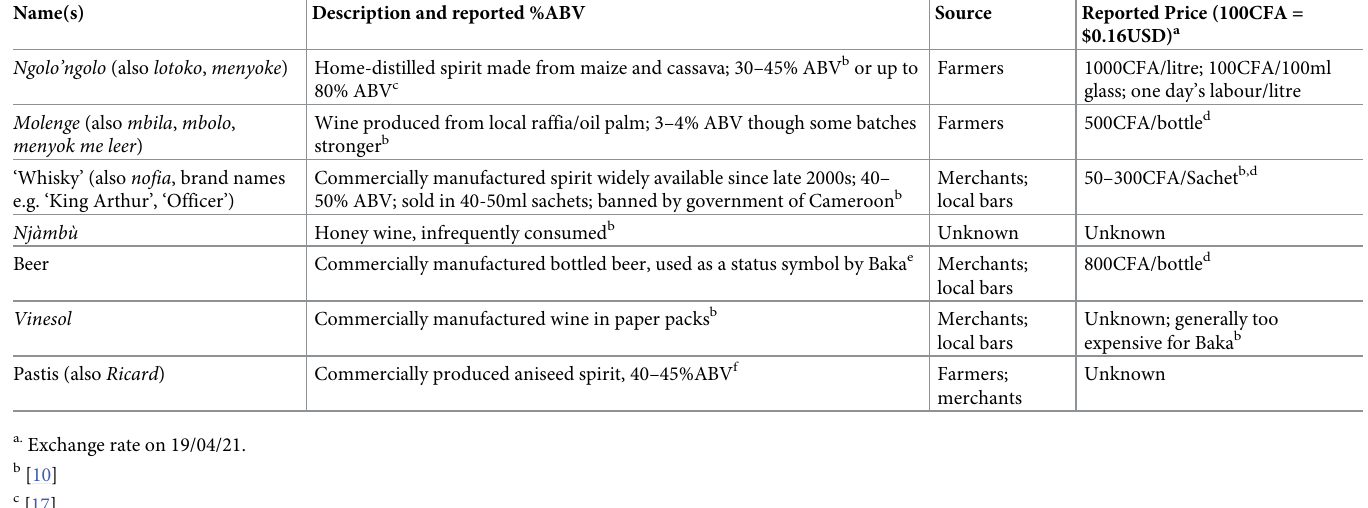
Table 1. Types and prices of alcoholic drinks previously reported in BaYaka